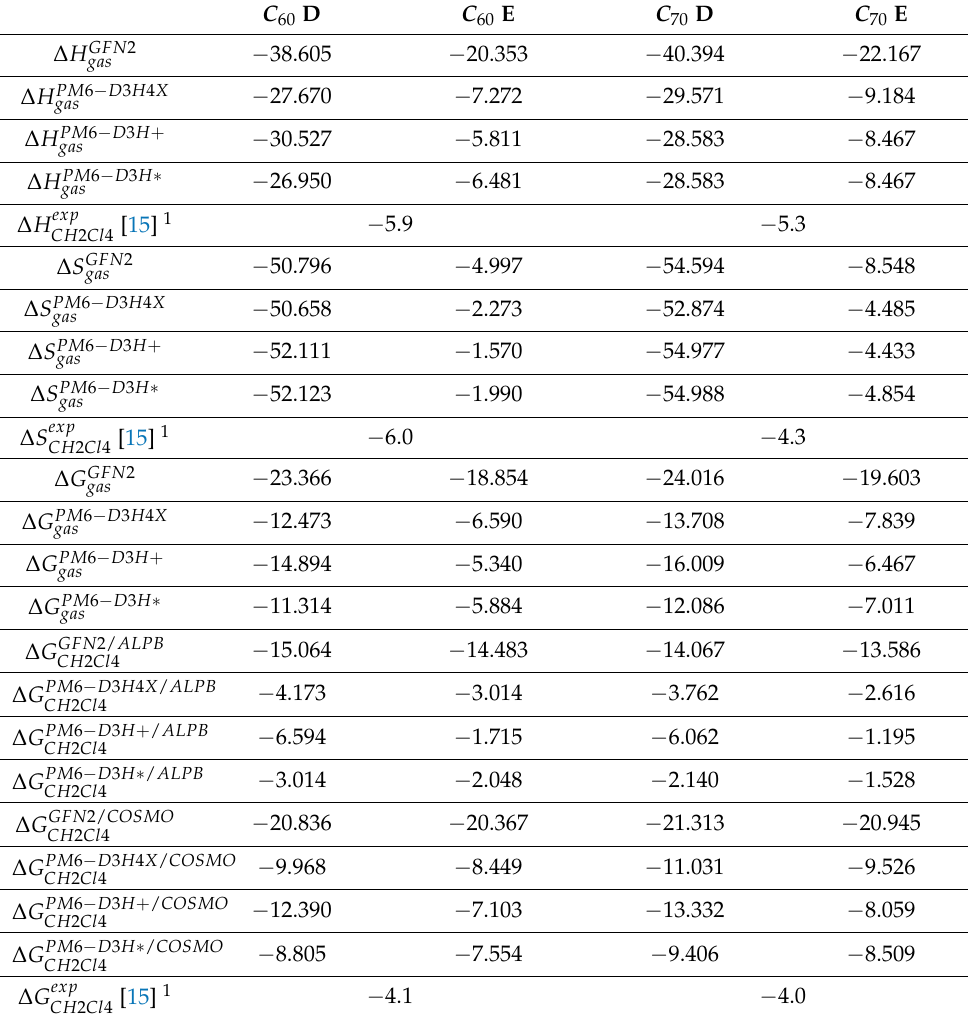
Table 4. Thermodynamic data referring to the formation of the adducts between fullerenes and the corannulene pincer according to two different modes: direct binding (D) in which a molecule of the buckycatcher captures a fullerene; exchange binding where fullerenes replace caged solvent molecules. Enthalpies and Gibbs free energies are given in kcal/mol, whereas entropies are in units of cal/(K.mol). Experimental data are given for comparison